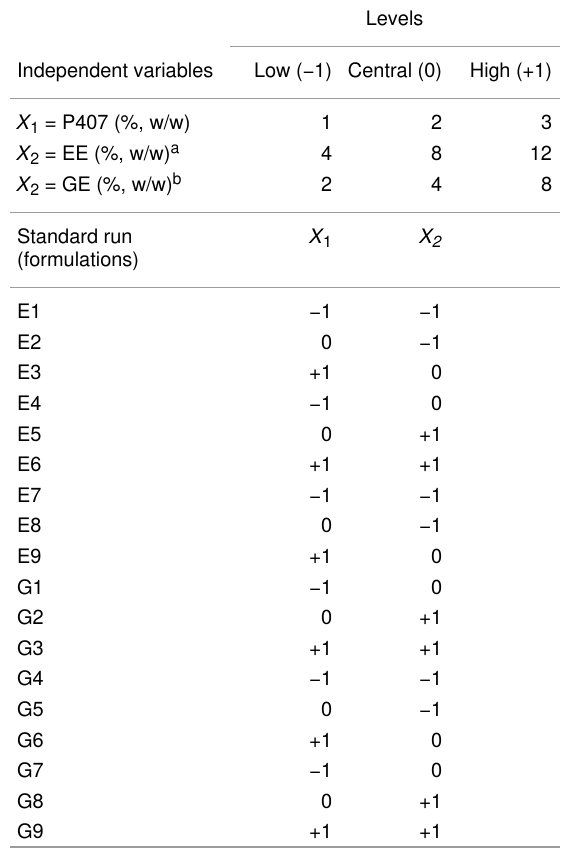
Table 5: Experimental 3 2 design utilized for the development of microneedles (MNs) composed of polyvinyl alcohol (PVA) and